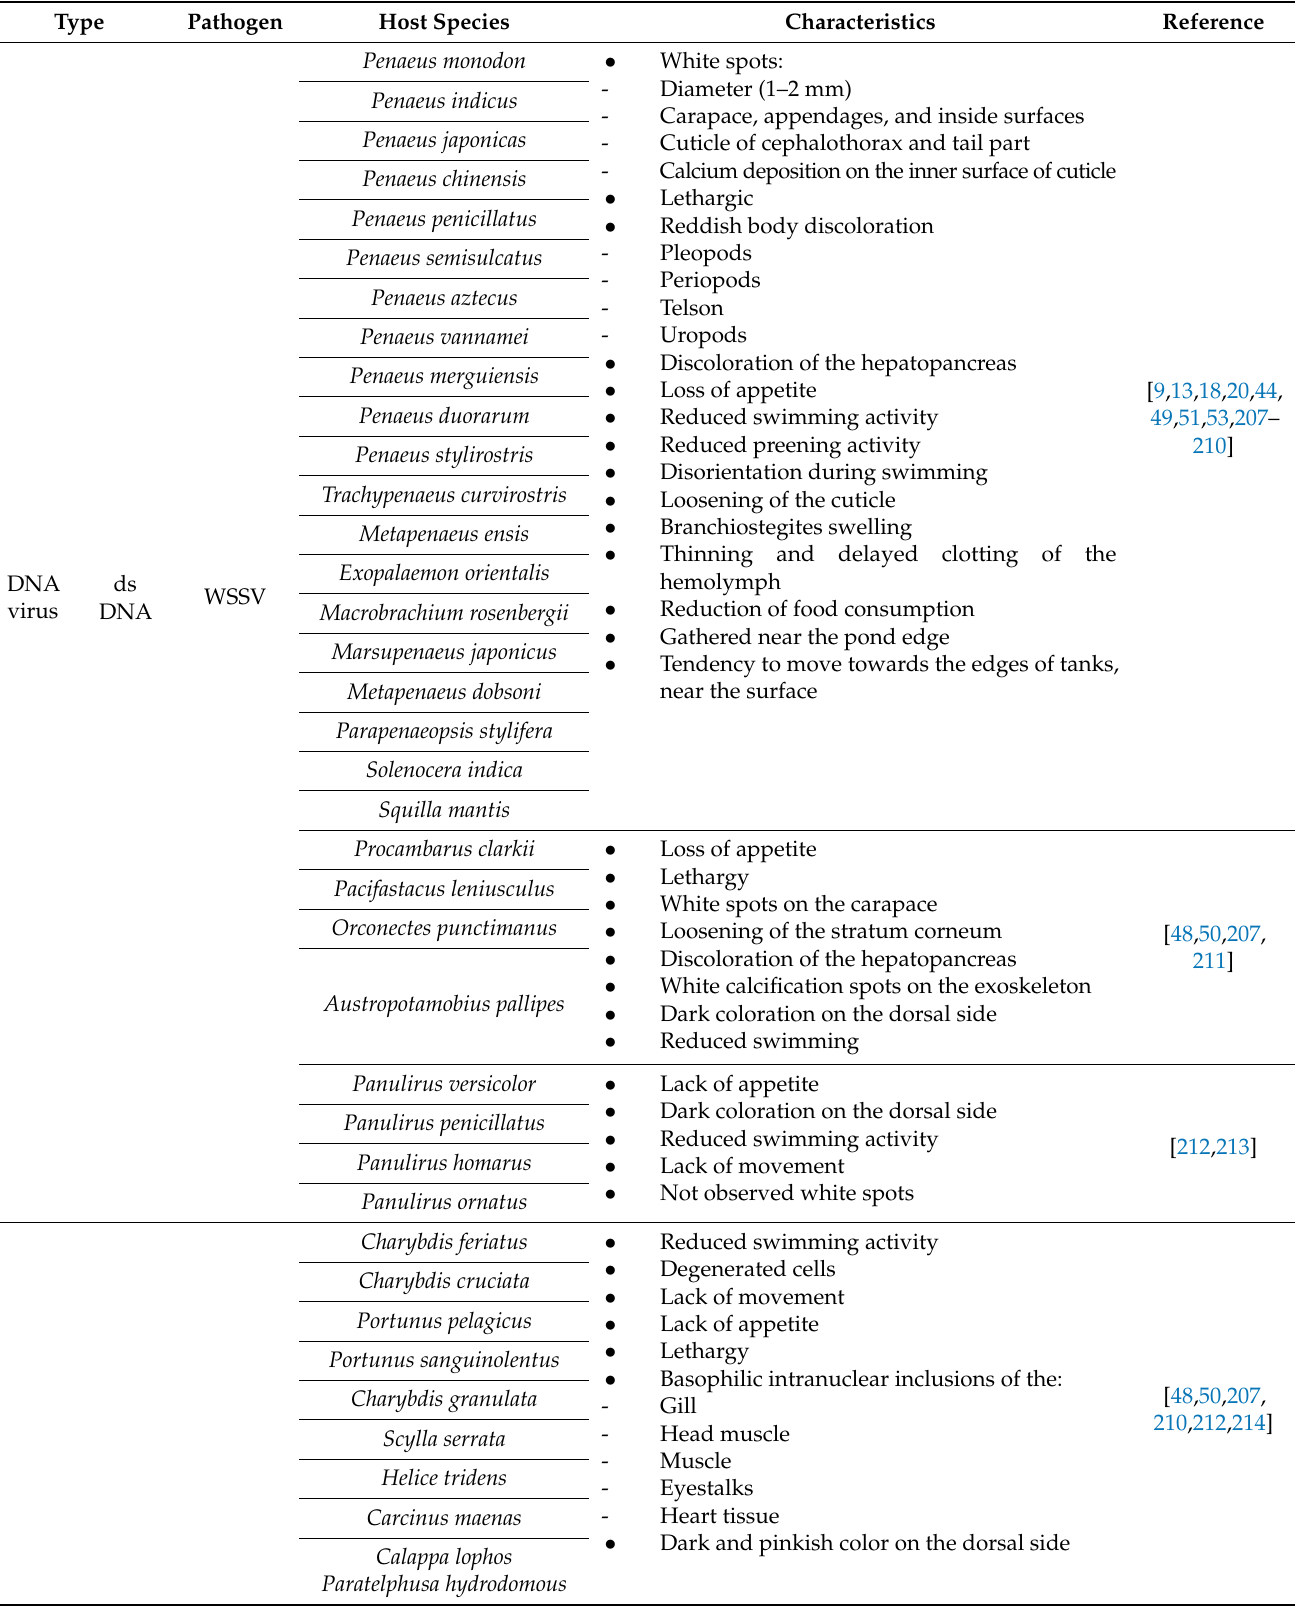
Table 4. Summary of host species following DNA and RNA viral disease